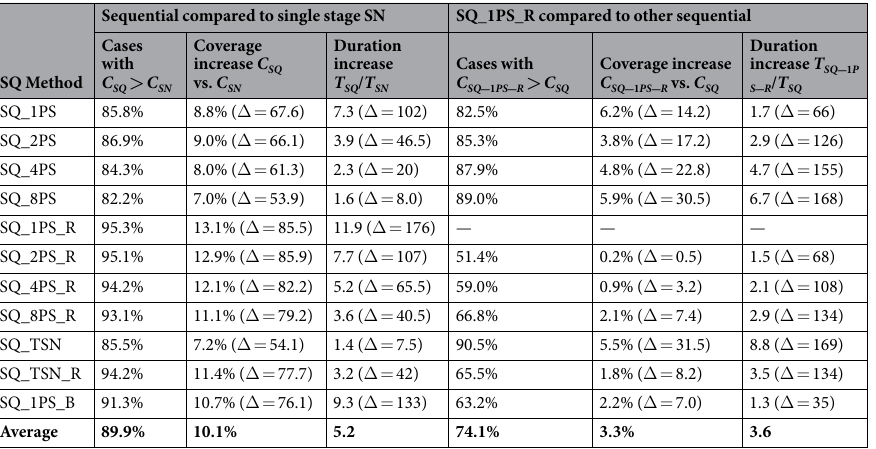
Table 3. Coverage and duration of various sequential methods compared to the worse single stage seeding SN and the best sequential approach SQ_1PS_R; Δ - Hodges-Lehmann estimator used in Wilcoxon signed rank test as a measure of the difference between two result groups; values Δ > 0 demonstrate significantly higher values for coverage and duration of all sequential strategies compared to single stage approach SN and SQ_1PS_R compared to other sequential approaches; all analysis achieved statistical significance p-value <